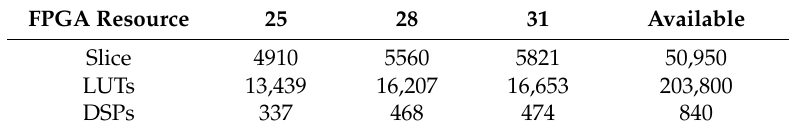
Table 2. Field-programmable gate (FPGA) resource usage comparison with different